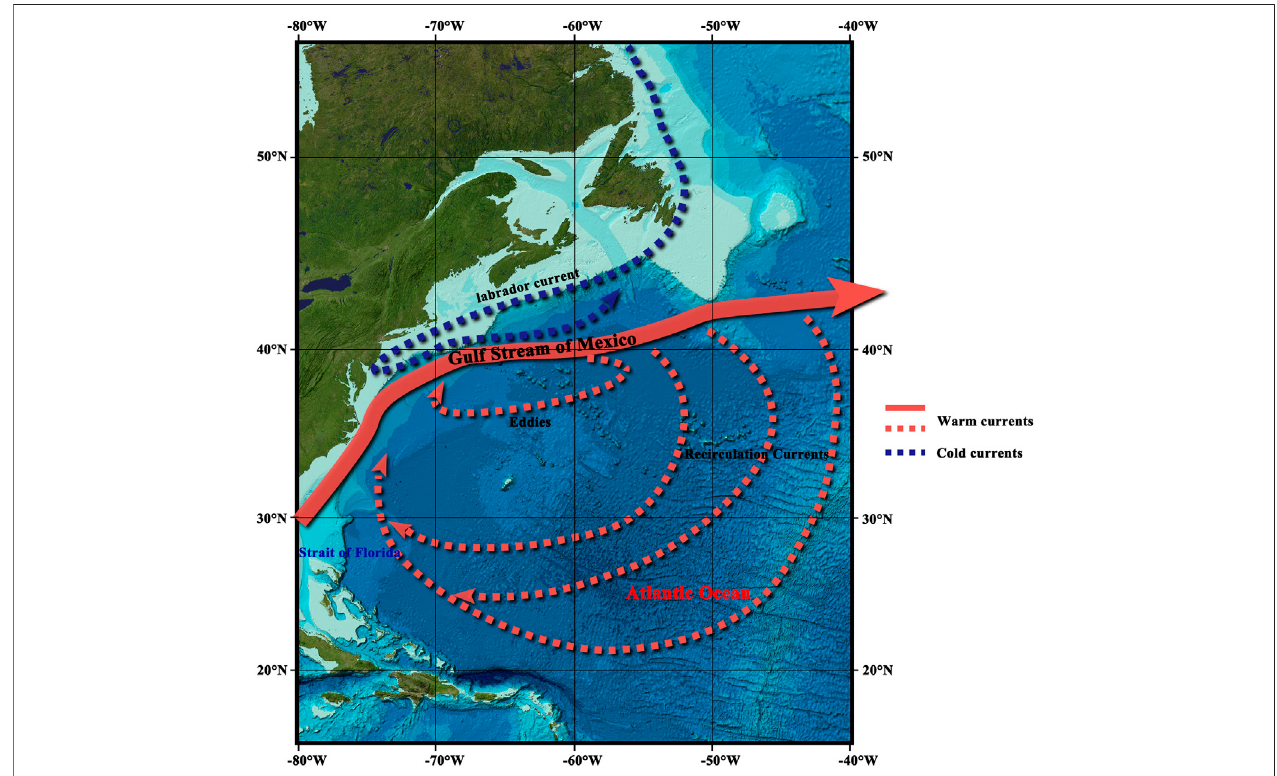
FIGURE 1 | The research area and the distribution of the Gulf Stream (image is adapted from the GEBCO world map 2014, www.gebco.net).